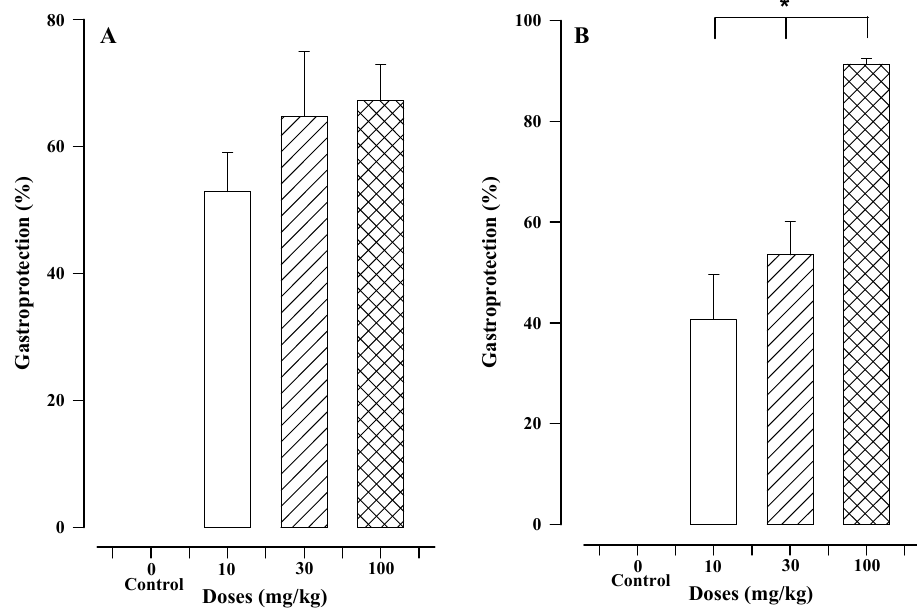
Figure 1. The gastroprotective effects of the white solid ( A ) and carbenoxolone ( B ). Bars represent the mean ± SEM ( n = 7). * p < 0.05, utilizing the Kruskal–Wallis test followed by Dunn’s multiple comparison.